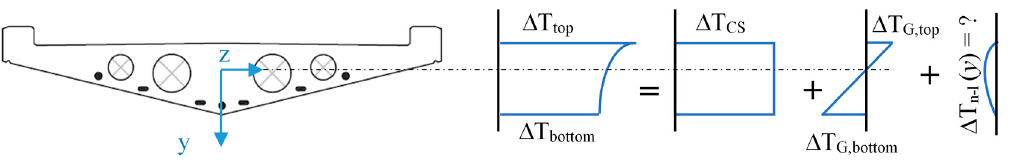
Figure 3. Example of a bridge cross-section with non-linear temperature distribution (causing non-linear thermal gradient).